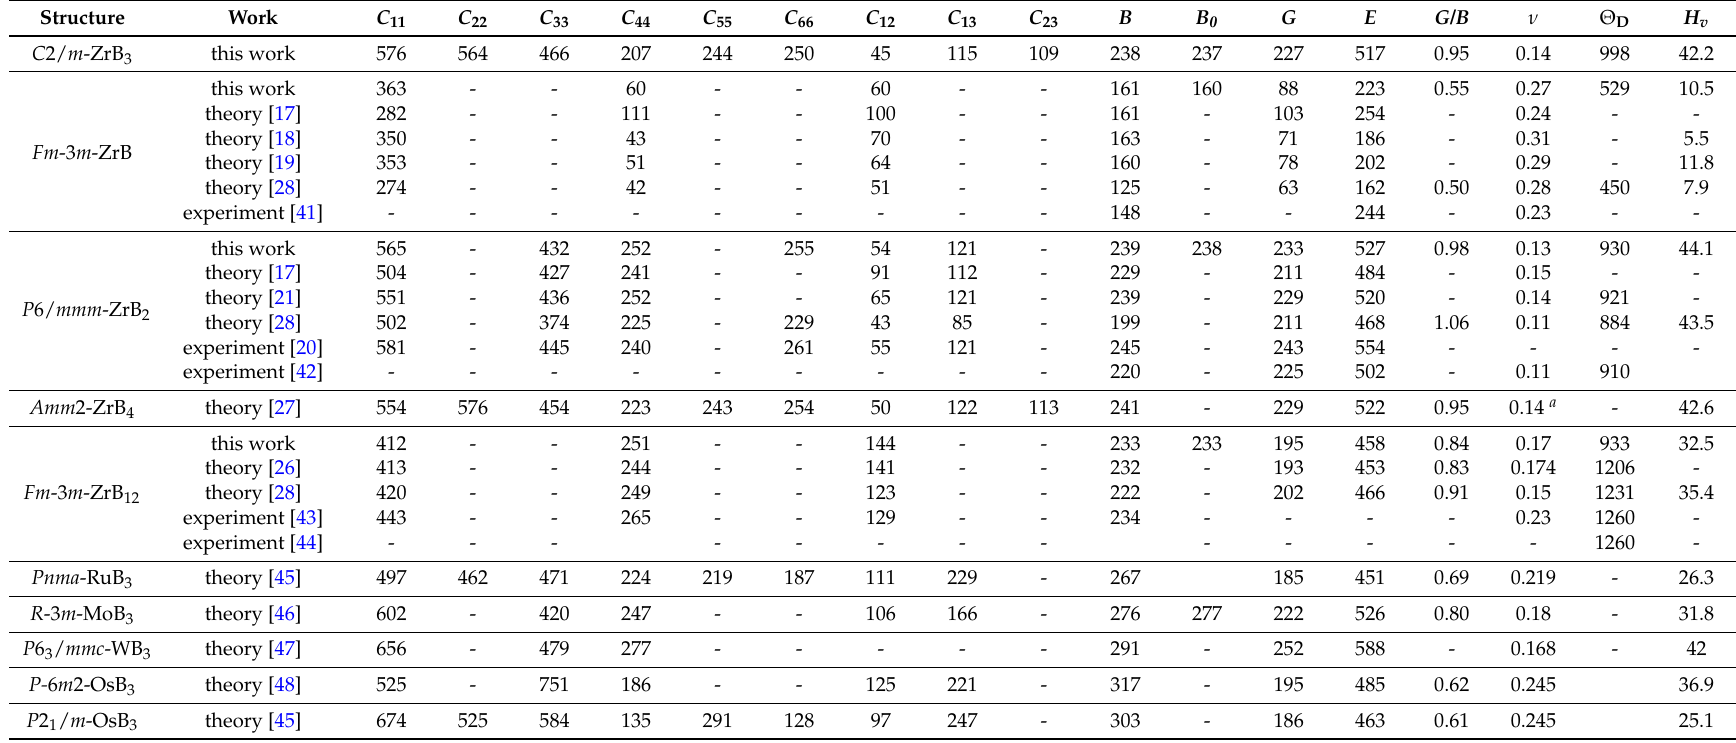
Table 1. The calculated elastic constants C ij (GPa), bulk modulus B (GPa), EOS fitted bulk modulus B 0 (GPa), shear modulus G (GPa), Young’s modulus E (GPa), G / B ratio, Poisson’s ratio v , Debye temperature Θ D (K), and hardness H v (GPa) for the C 2/ m -ZrB 3